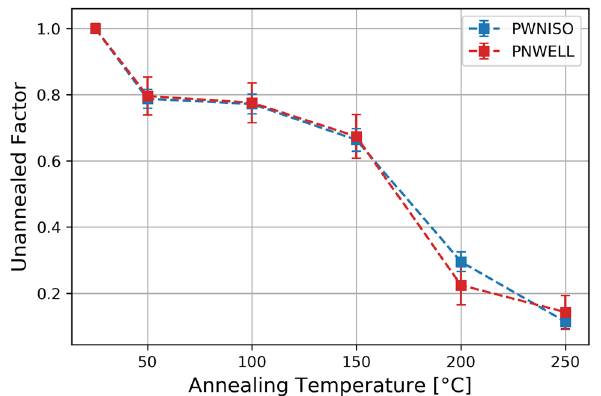
Figure 13. Evolution of the remaining RTS pixels for different annealing